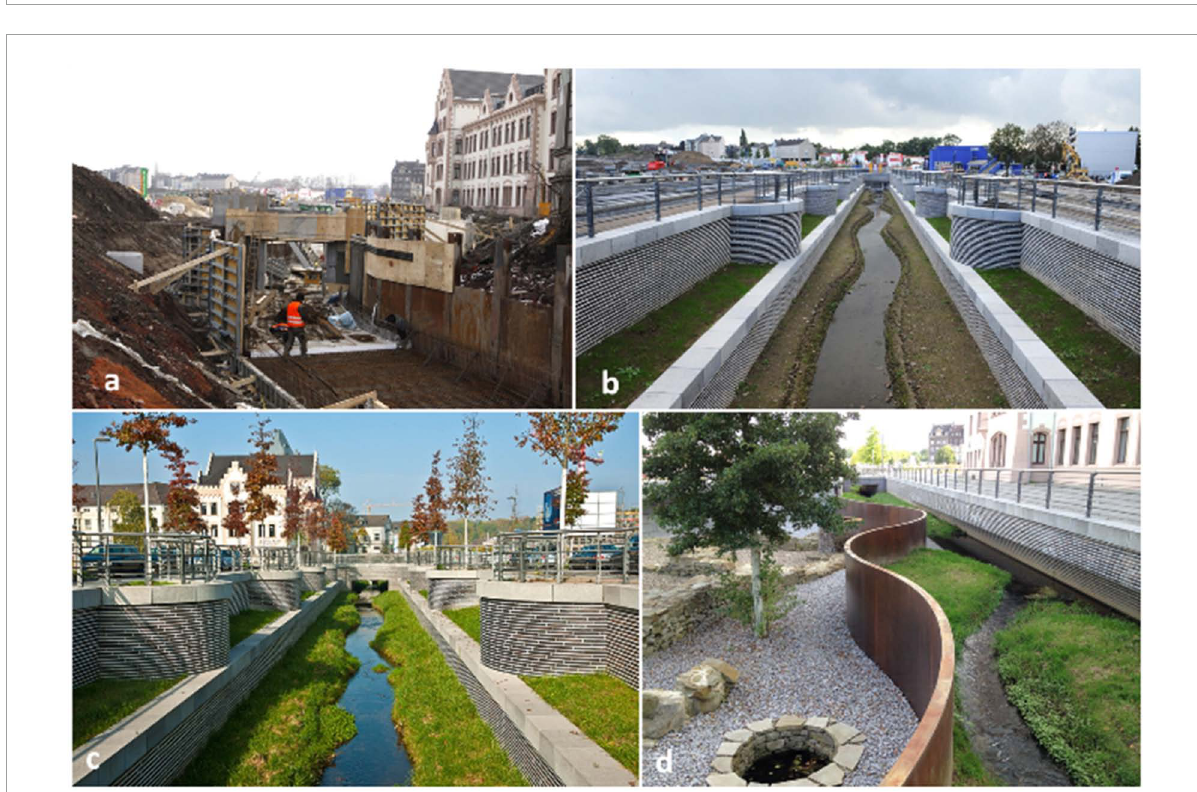
FIGURE8 Hörder Bach restoration process including (a) preparation for the daylighting in front of Hörder castle, (b) daylighting Hörder stream via removal of part of the street. (c) Hörder stream a few years after daylighting. (d) Historical excavations and the lower section of Hörder stream in front